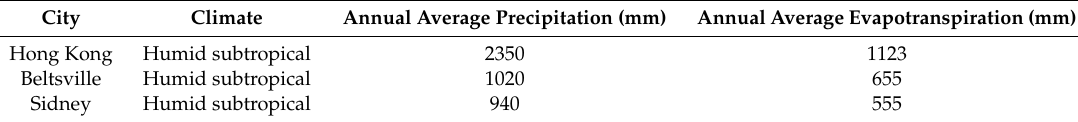
Table 2. General climatic characteristics of Hong Kong, Beltsville and